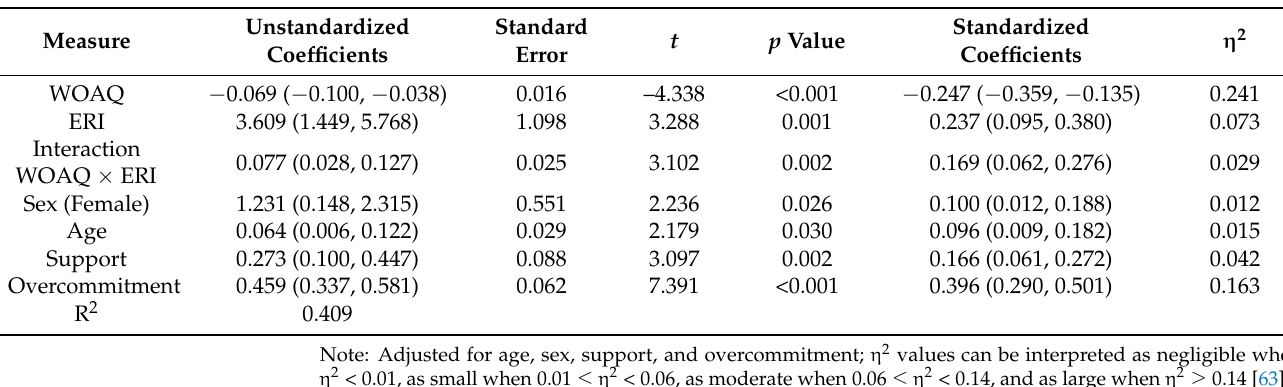
Figure 2. Diagram of the ERI model. Note: ***: p < 0.001; **: p < 0.01; * p < 0.05.